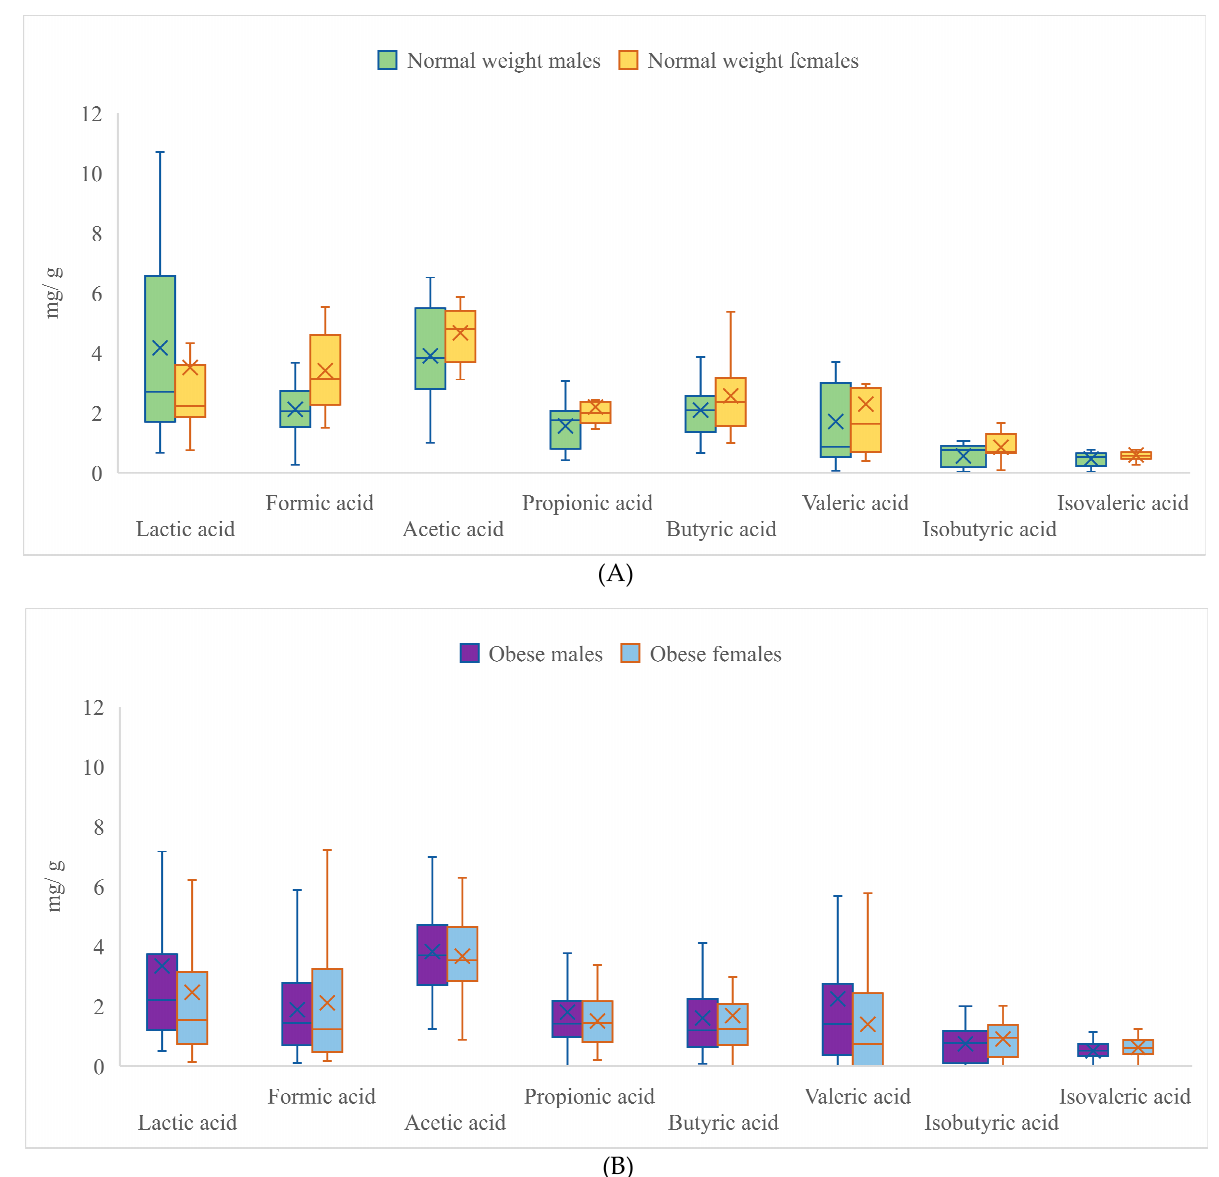
Figure 2. Concentrations of lactic acid, SCFAs, and BCFAs differentiated between males and females and according to anthropometric status (A) – presents data of normal weight males and females; (B) – presents data of obese males and females.